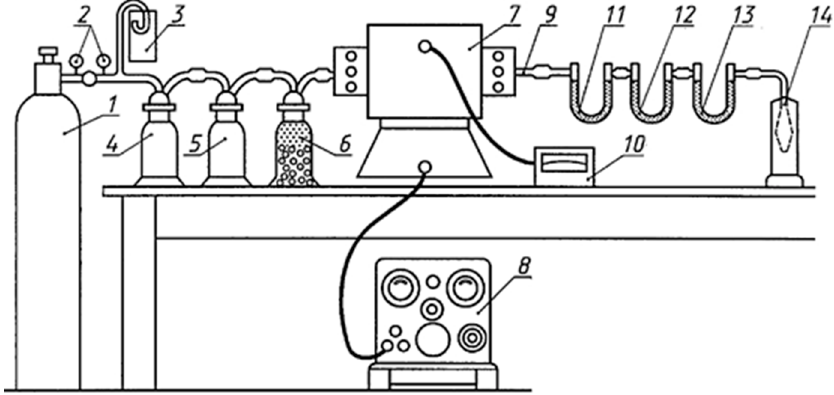
Figure 2. Equipment used to determine the proportion of free carbon